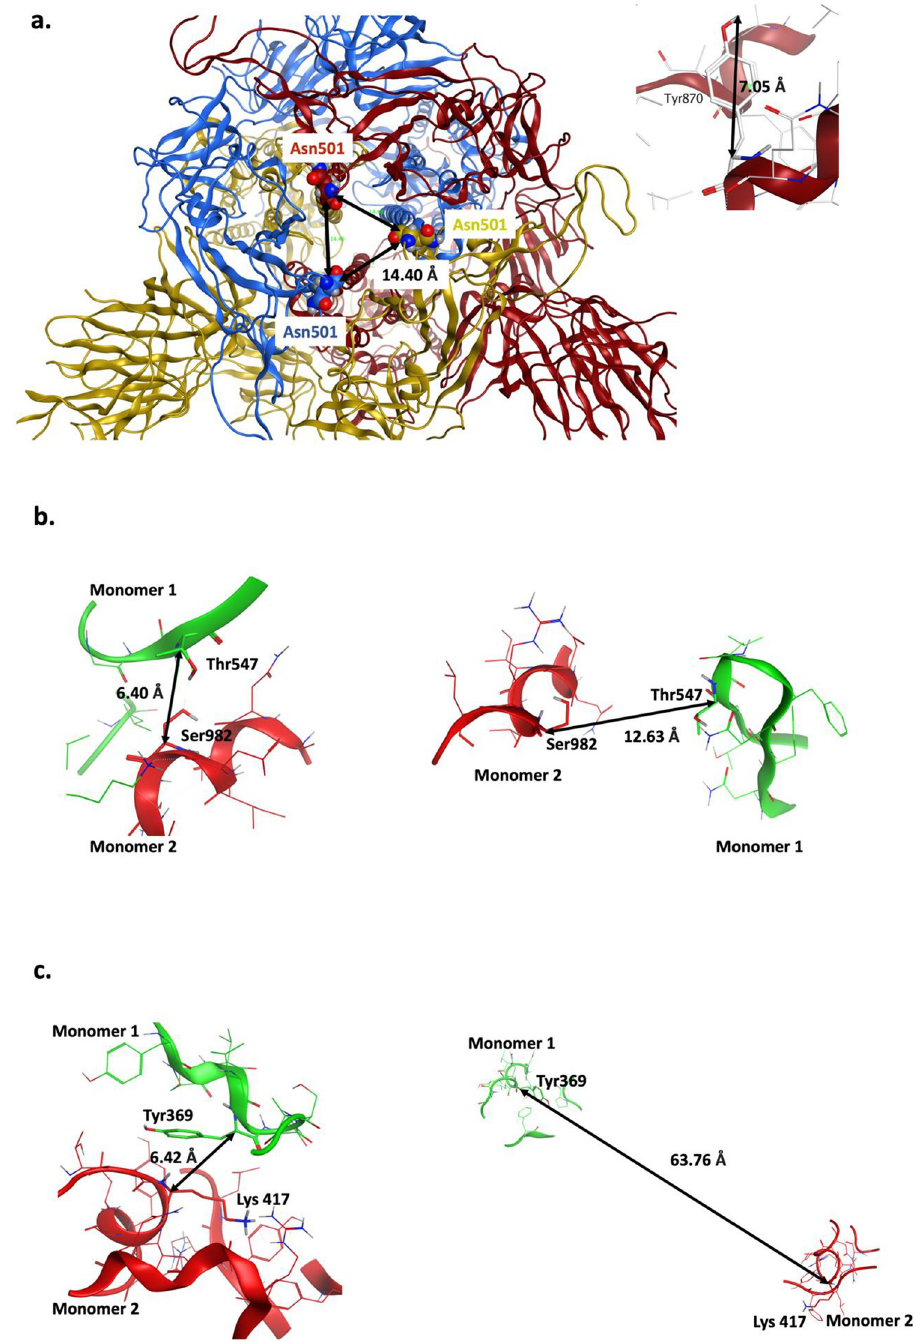
Fig 3. Potential destabilizing effects of the point mutations on the closed conformation of the spike protein trimer. (a) Distance between the backbones of Asn501 in closed conformation is shown (left) and typical length of Tyr side chain is shown (right). Asn501Tyr mutation might introduce steric clashes and destabilize the closed conformation. (b ) Ser982 (monomer 2)-Thr547 (monomer 1) interaction in closed (left) and open (right) conformation. Ser982Ala results in loss of this inter-monomeric interaction. (c) Lys417 (monomer 2)-Tyr369 (monomer 1) interaction in closed (left) and open (right) conformation. Lys417Asn mutation may reduce this inter- monomeric